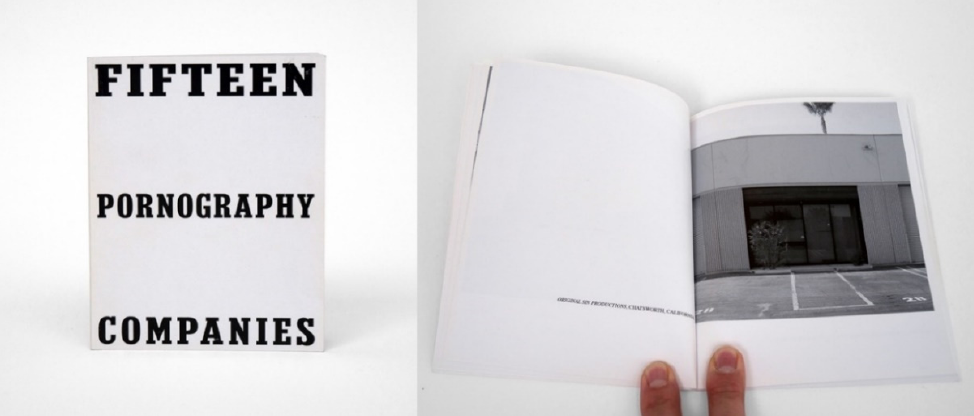
Figure 27. Louisa Van Leer, Fifteen Pornography Companies , 2006.